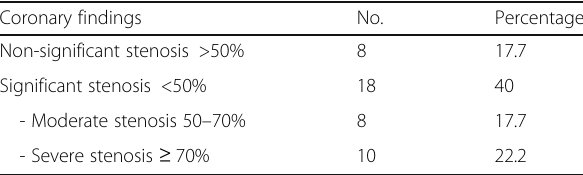
Table 3 Number of patients with different degrees of coronary artery disease Coronary findings